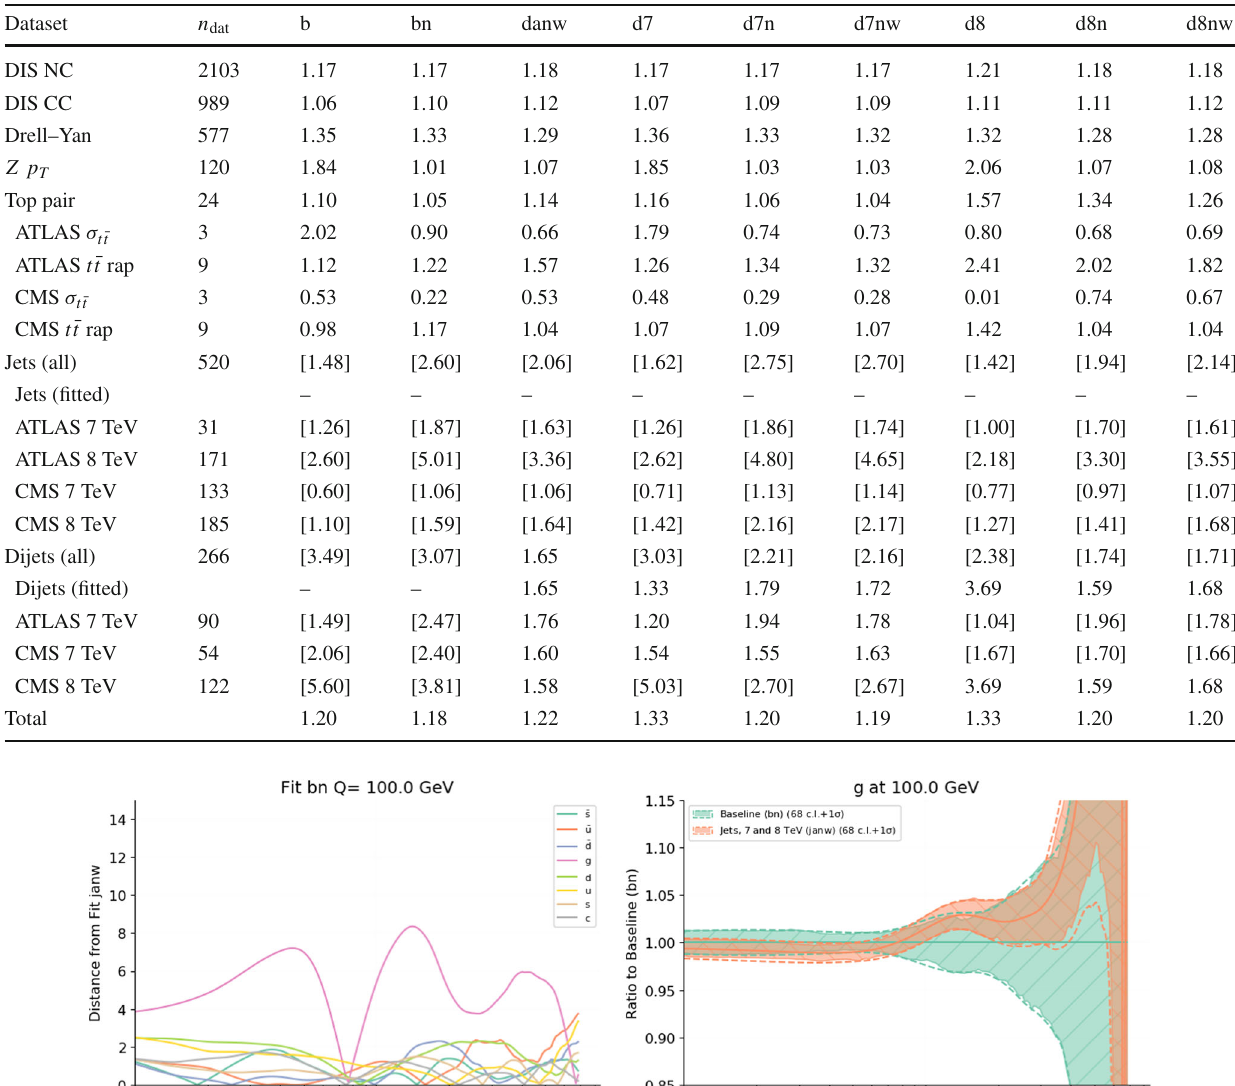
Table 4 Same as Table 3, but now for dijets. The baseline is repeated for ease of reference Dataset